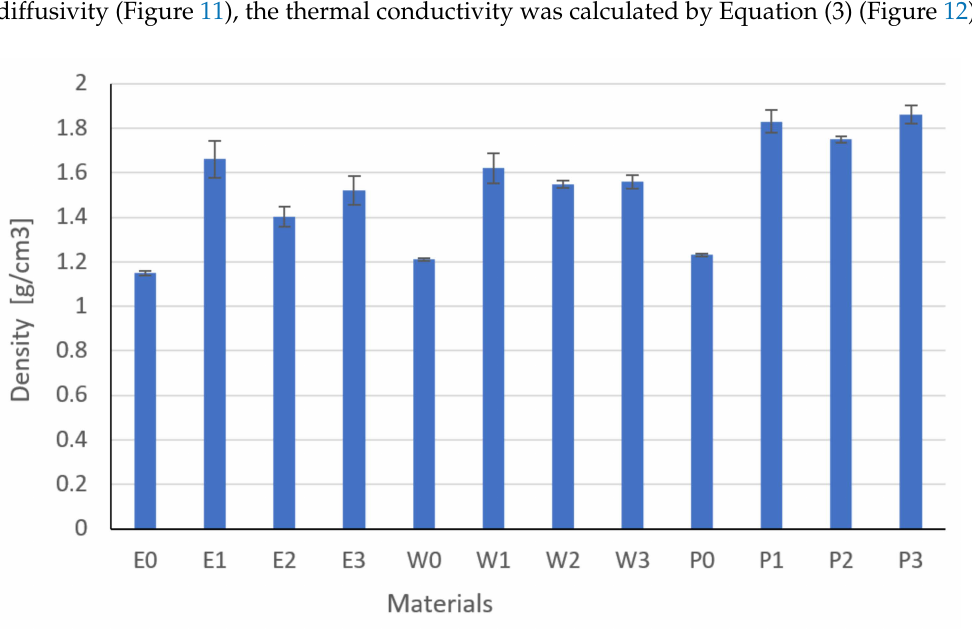
Figure 9. Results of